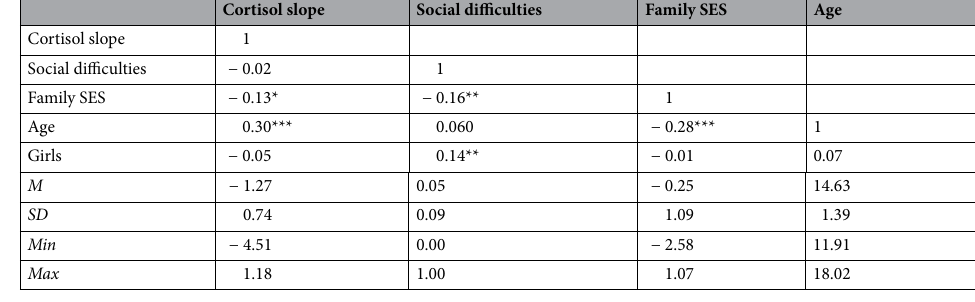
Table 1. Bivariate correlations between study constructs. ***p < 0.001, **p < 0.01, *p < 0.05. Values for time- varying variables (i.e., cortisol slope and social difficulties) are person-mean values averaged across all days within an individual adolescent. The sample was 57%